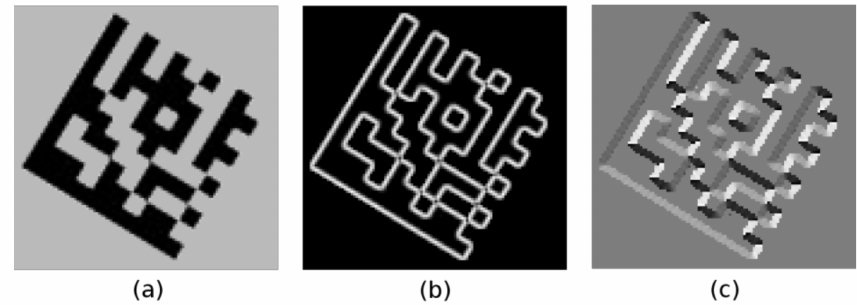
Figure 3. ( a ) grayscale image; ( b ) gradient magnitude image; ( c ) gradient direction image.